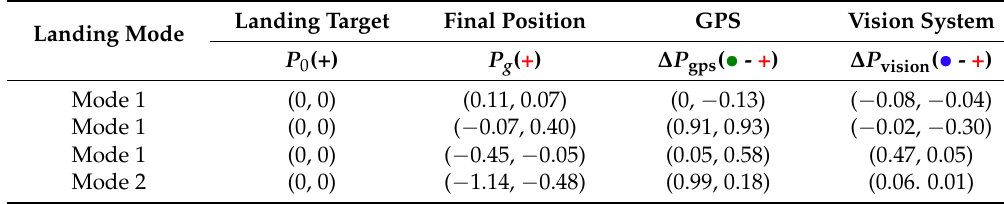
Figure 12. Mode 2 (GPS-based landing): ( a ) After descending a certain height, the estimated position of vision system (blue dot) was more accurate than the GPS (green dot); ( b ) The corresponding template matching result indicated that the UAV’s position was approximately 1.2 m away from the designated landing spot. Table 1. Comparison of positioning performance. (unit: m).